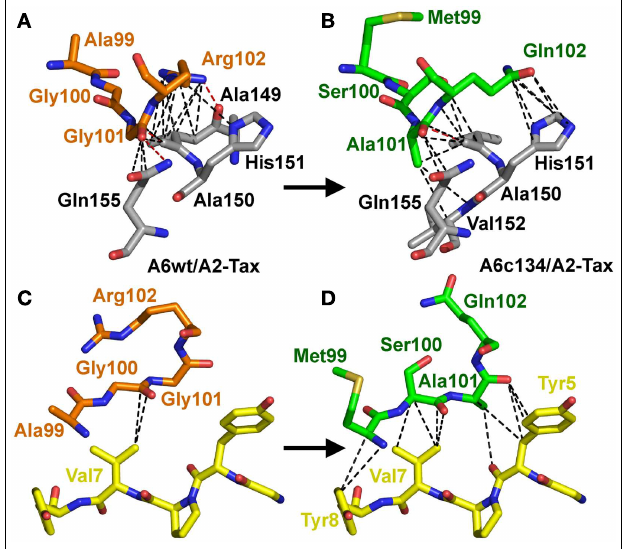
FIGURE 4 | Increased peptide contacts betweenA6c134TCR and A2-Tax mediate the high affinity binding . Specific contacts ( < 4Å) made by residues 99–102 in theTCR CDR3 β -chain of either: AGGR (A6wtTCR) or MSAQ (A6c134TCR). (A) Contacts (dotted lines) between the A6wtTCR CDR3 β chain, residues 99–102 (AGGR) (shown in orange sticks) and the MHC (gray sticks). (B) Contacts (dotted lines) between the A6c134TCR CDR3 β chain, residues 99–102 (MSAQ) (shown in green sticks) and the MHC (gray sticks). (C) Contacts (dotted lines) between the A6wtTCR CDR3 β chain, residues 99–102 (AGGR) (shown in orange sticks) and the peptide (yellow sticks). (D) Contacts (dotted lines) between the A6c134TCR CDR3 β chain, residues 99–102 (MSAQ) (shown in green sticks) and the peptide (yellow sticks). Contacts between the A6c134 and the MHC remain similar to the A6wt/A2-Tax complex whereas A6c134-peptide contacts are